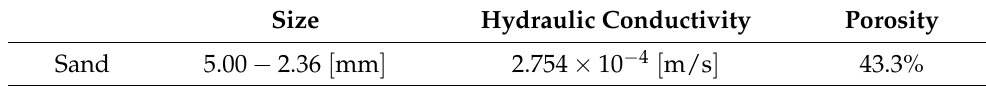
Table 1. The characteristics of sand.